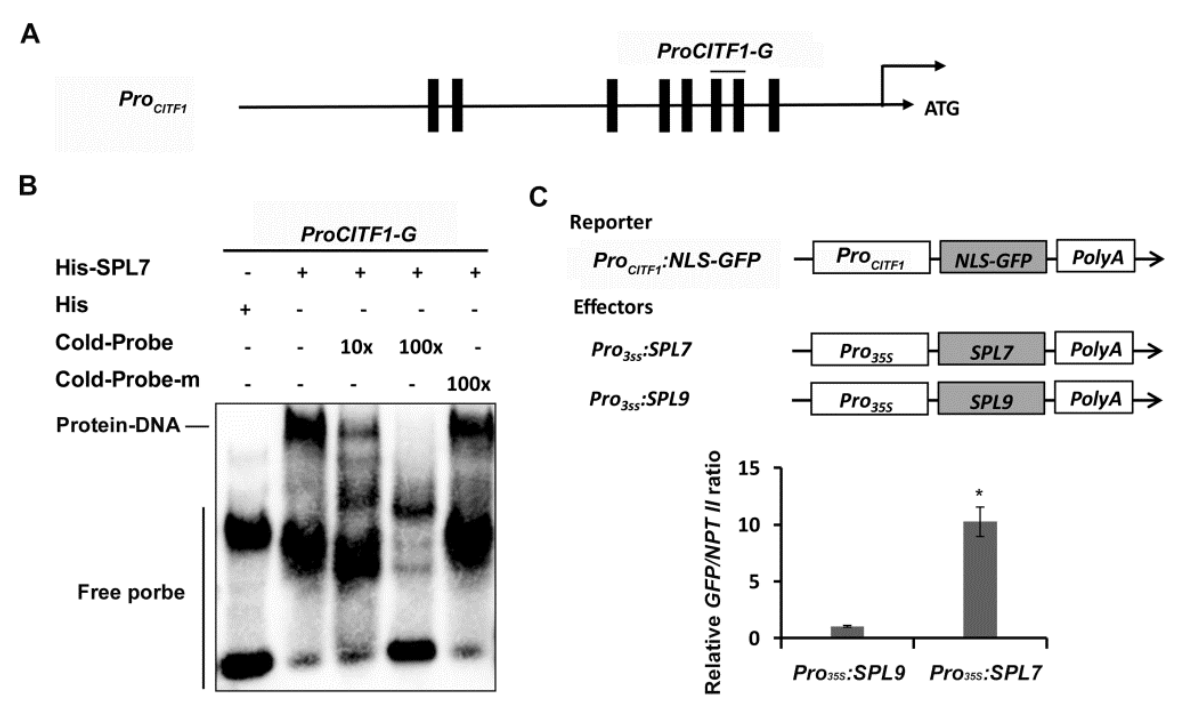
Figure 2. SPL7 directly activates CITF1. ( A ) GTAC-boxes are indicated in the CITF1 promoter. ( B ) EMSA showing that SPL7 directly binds to the promoter of CITF1 . Either His-SPL7 or 6 × His was incubated with the biotin-labeled probes. Biotin-probe, biotin-labeled probe; cold-probe, unlabeled probe; cold-probe-m, unlabeled mutated probe with mutated GTAC-boxes . ( C ) Activation of CITF1 promoter by SPL7. The CITF1 promoter was used to drive the NLS-GFP as the reporter. SPL7 and SPL9 driven respectively by the CaMV 35S promoter were used as the effectors. The SPL9 was used as a negative control effector. The GFP/NPT II ratio represents the GFP transcript abundance relative to the internal control NPT II transcript. Data represent arithmetic means ± SD ( n = 3). Different letters above each bar indicate statistically significant differences (ANOVA, p < 0.01).